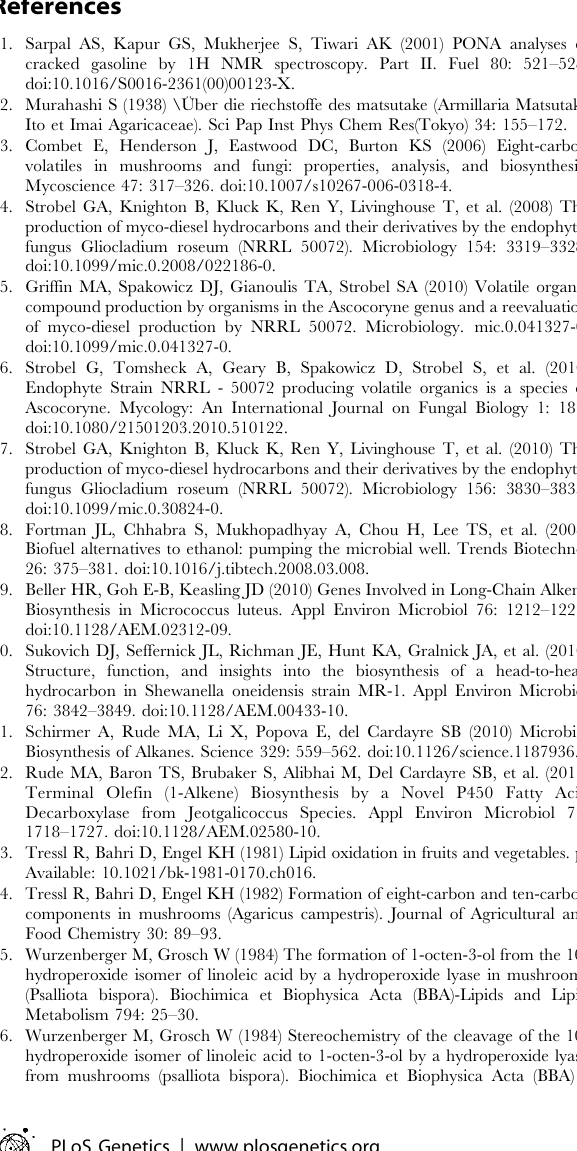
Table S14 Expression values (log 2 RPKM Quantile Normal- ized) for the potential fabG genes (IP011284). For each Gene ID, expression levels are listed for each culture condition. Genes correlated with C8 production are highlighted in yellow. Table S15 Summary Statistics of Differential Gene Expression. The number of genes expressed (quantile normalized log 2 RPKM) in each culture condition (Illumina RNA-seq) relative to expression in PD9 (454 long reads). Gene counts are given for six RPKM fold thresholds from 2 to 2 2. (PDF) Text S1 Supporting information including additional methods used for and results from the Expanded Association Analysis, Genome Annotation, Models and Clusters, Comparative Geno- mics, and Transcriptome.